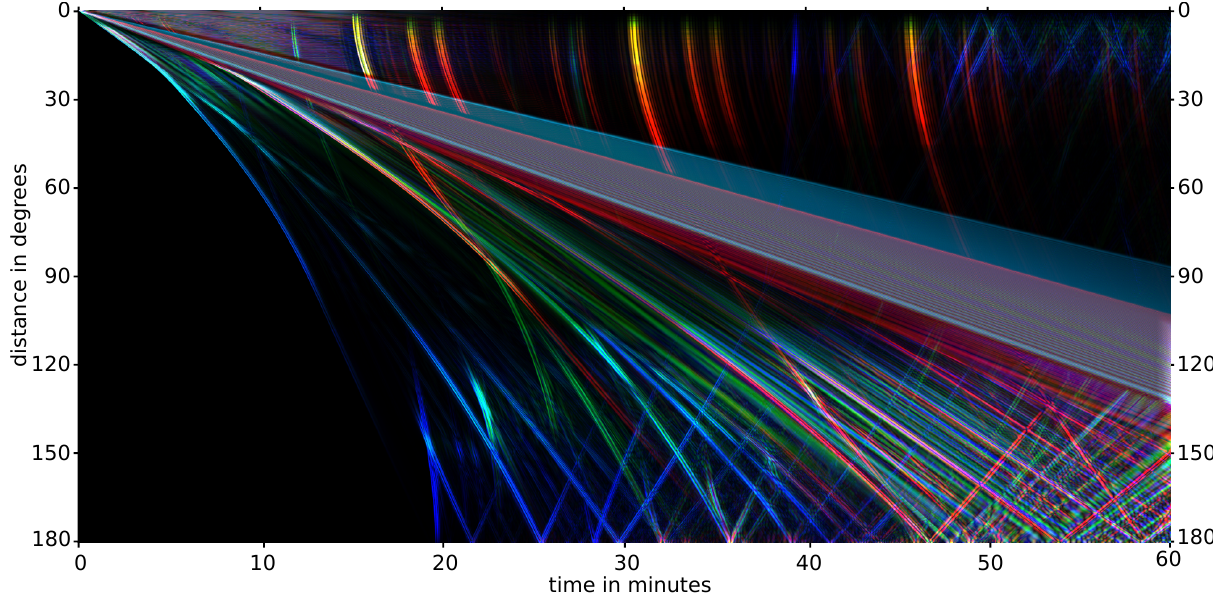
Figure 1. Global stack of 1h of seismograms accurate to a shortest period of 2s for an earthquake in 27km depth computed with Instaseis. The displacement is color-coded analogous to the IRIS global stack (Astiz et al., 1996), i.e. red: transversal component, green: radial compo- nent, blue: vertical component. An automatic gain control (AGC) with a window of 100s length is used to balance large amplitude variations between the various phases. Note that creating this plot does not require to define the source depth at the time of database calculation. A high-resolution version of this plot and one for 5h long seismograms is added as an electronic